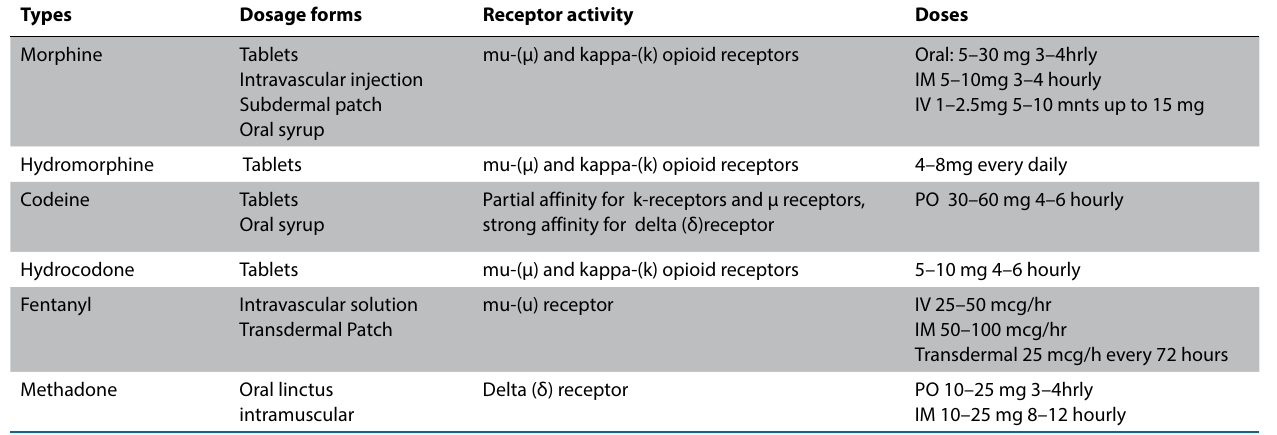
Table 8 : Formulations, receptors and doses of opioids